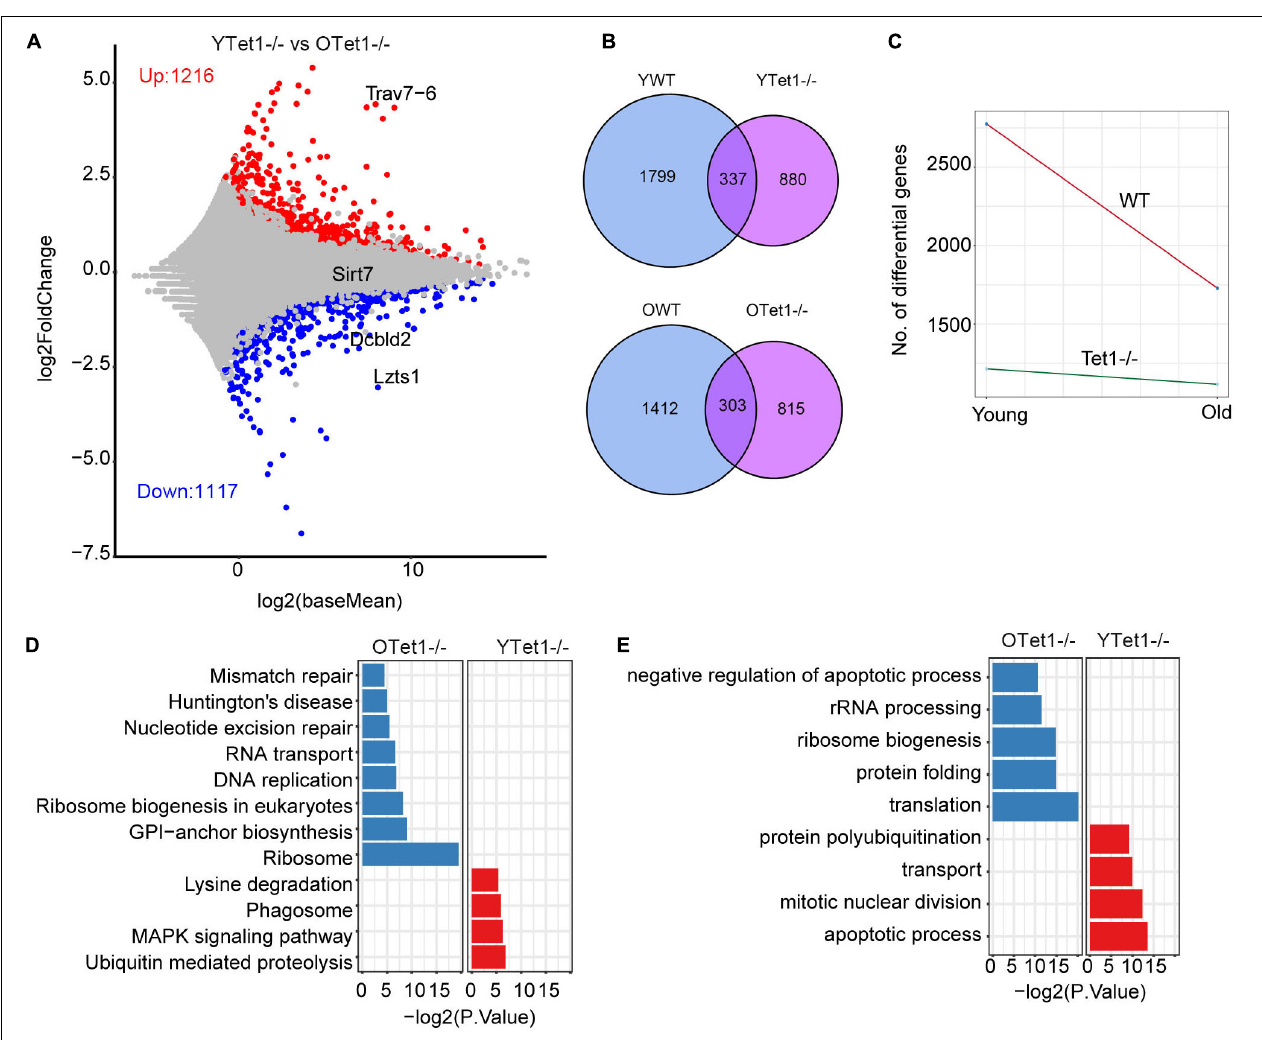
FIGURE 4 | Differential gene expression between young and old Tet1 − / − oocytes. (A) Scatter plot displaying differential gene expression between young and old Tet1 − / − oocytes. (B) Venn plot showing the upregulated and downregulated genes between young and old WT oocytes, and young and old Tet1 − / − oocytes. (C) Slope plot showing the change between WT and Tet1 − / − oocytes. (D) KEGG enrichment results of differential genes between young and old Tet1 − / − oocytes. X -axis represents the p -value. (E) GO enrichment results of differential genes between young and old Tet1 − / − oocytes. X -axis represents the p -value.